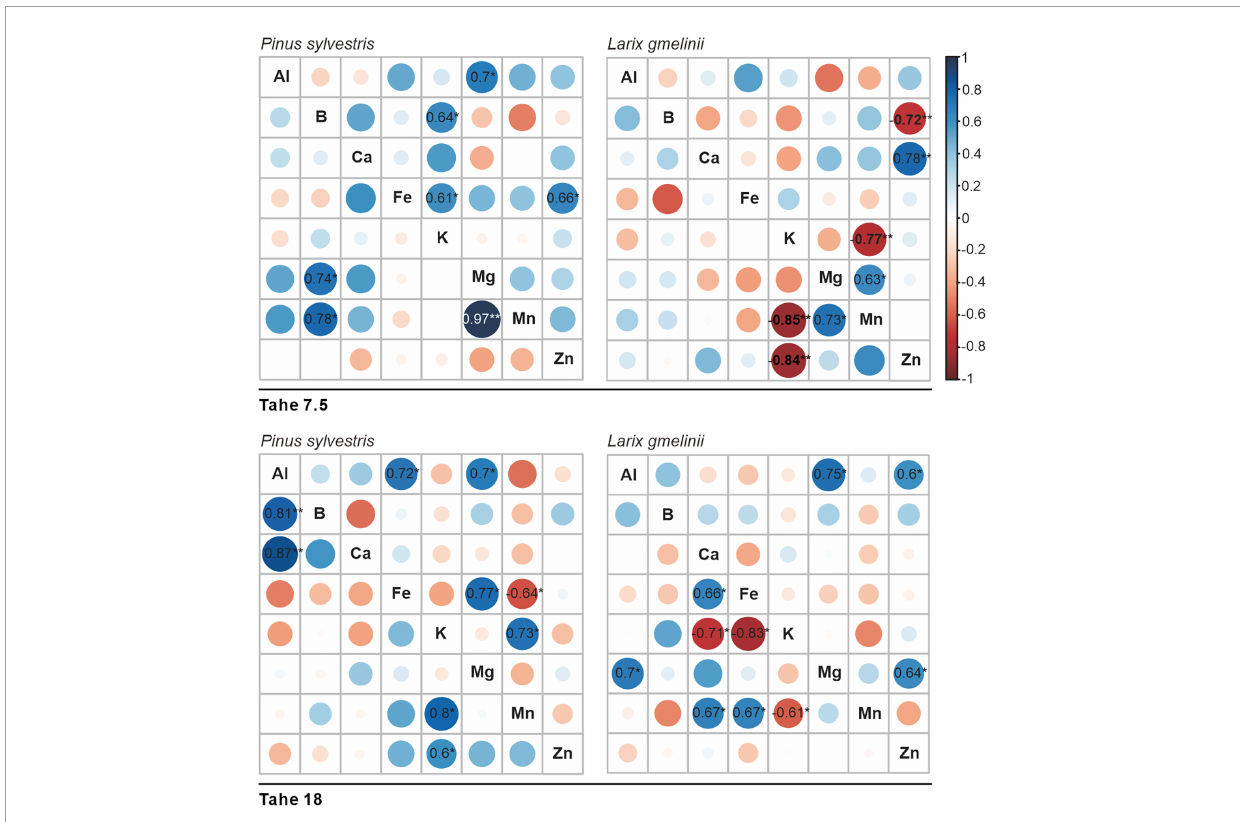
FIGURE5 Correlation matrix plot between element concentrations in Tahe 7.5 and Tahe 18 in the burned area before (above the diagonal) and after (under the diagonal) the fire. Pearson correlation coefficients with significance levels were listed (* P < 0.05, ** P <